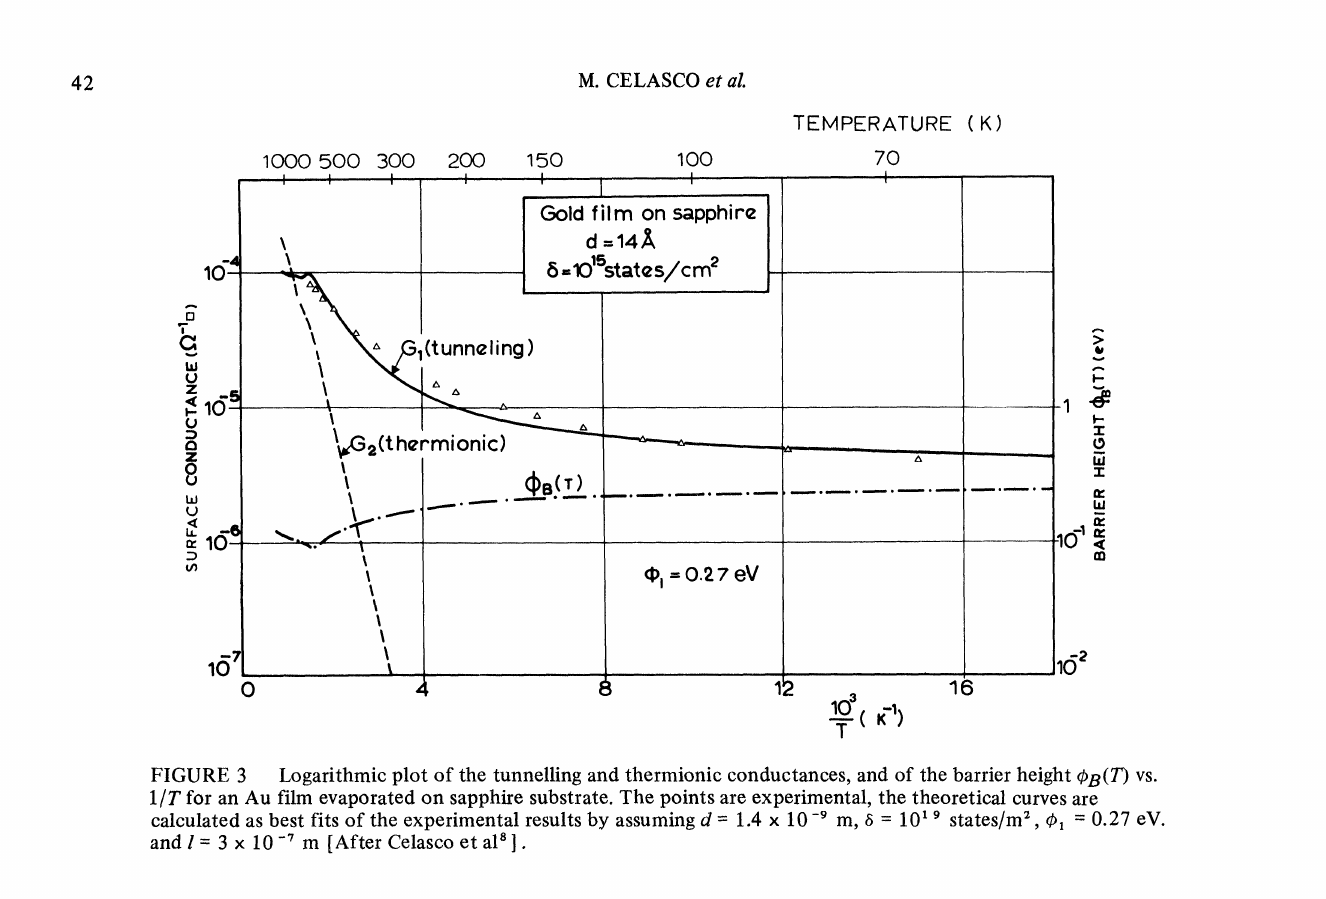
FIGURE 3 Logarithmic plot of the tunnelling and thermionic conductances, and of the barrier height bB(T) vs. lIT for an Au film evaporated on sapphire substrate. The points are experimental, the theoretical curves are calculated as best fits of the experimental results by assuming d 1.4 x 10 m, 6 1019 states/m 1 0.27 eV. and 3 x 10 m [After Celasco et al